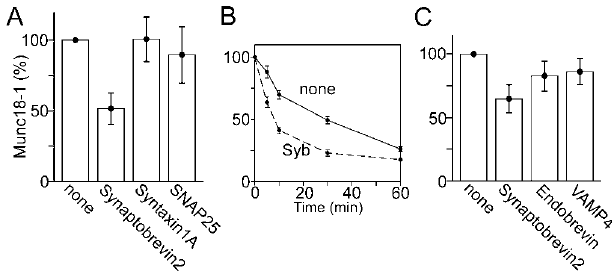
Figure 4. Synaptobrevin 2 Releases Munc18–1 from Complexed Syntaxin (A) Membrane sheets were incubated for 10 min in the absence (set to 100%) or presence of 10 l M of recombinant SNARE proteins as indicated, and Munc18–1 was quantified by immunofluorescence. Each experiment was performed six to seven times, values are given as mean 6 standard deviation of the mean (SDM). Paired t -test analysis none:synaptobrevin 2 p , 0.0005 ( n ¼ 7); t -test synaptobrevin:SNAP-25 p , 0.005 ( n ¼ 6). (B) Incubation of membrane sheets with or without 10 l M synaptobrevin 2 for varying times, as indicated, followed by immunostaining for Munc18–1. Immunostaining intensity of immediately fixed membrane sheets was set to 100%. For each data point, four to six independent experiments were performed. Values are given as mean 6 SEM. (C) Experiment as in (A), R-SNAREs were added during incubation as indicated. Values are given as mean 6 standard deviation of the mean (SDM). Paired t -test synaptobrevin 2:none p , 0.00005 ( n ¼